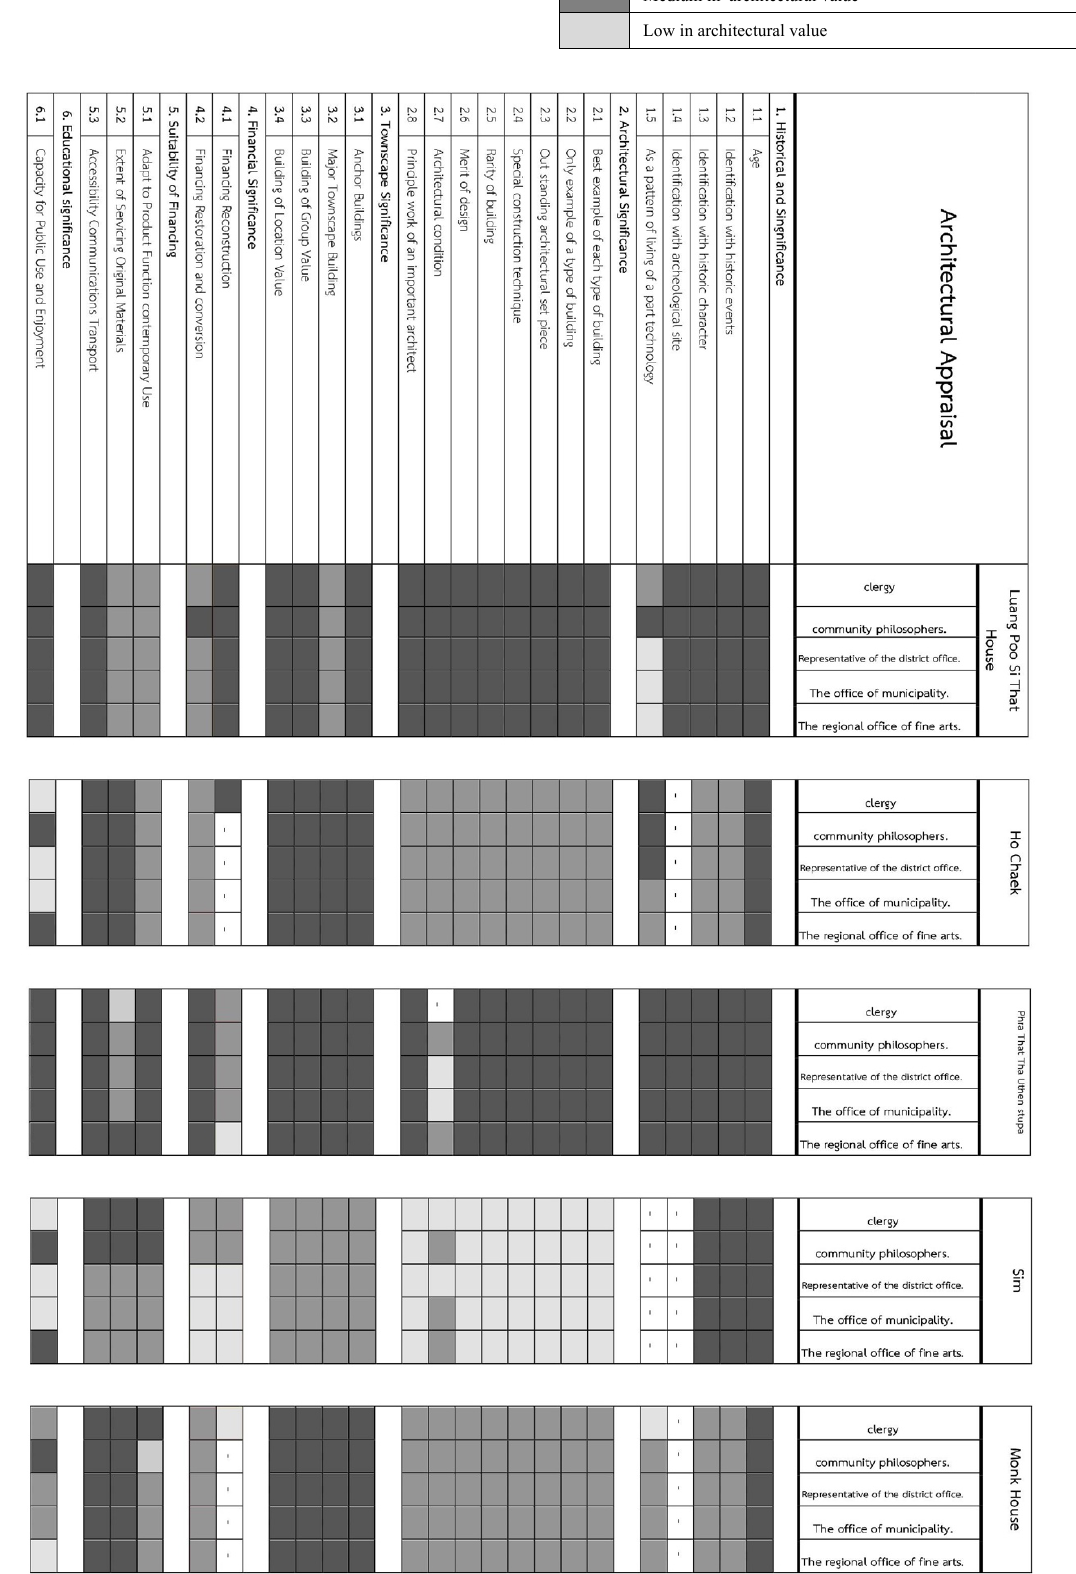
Table 1. Architectural evaluation of the 5 buildings through stakeholders'